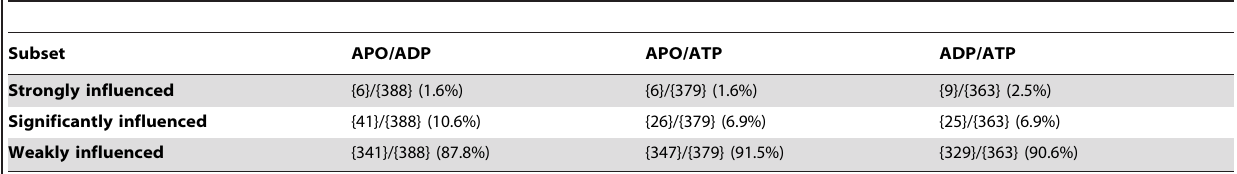
Table 2. Statistical analysis of the dissimilarity [ 1-H( c i ) ] of the FEPs between concatenated MD runs in different nucleotide-binding states.